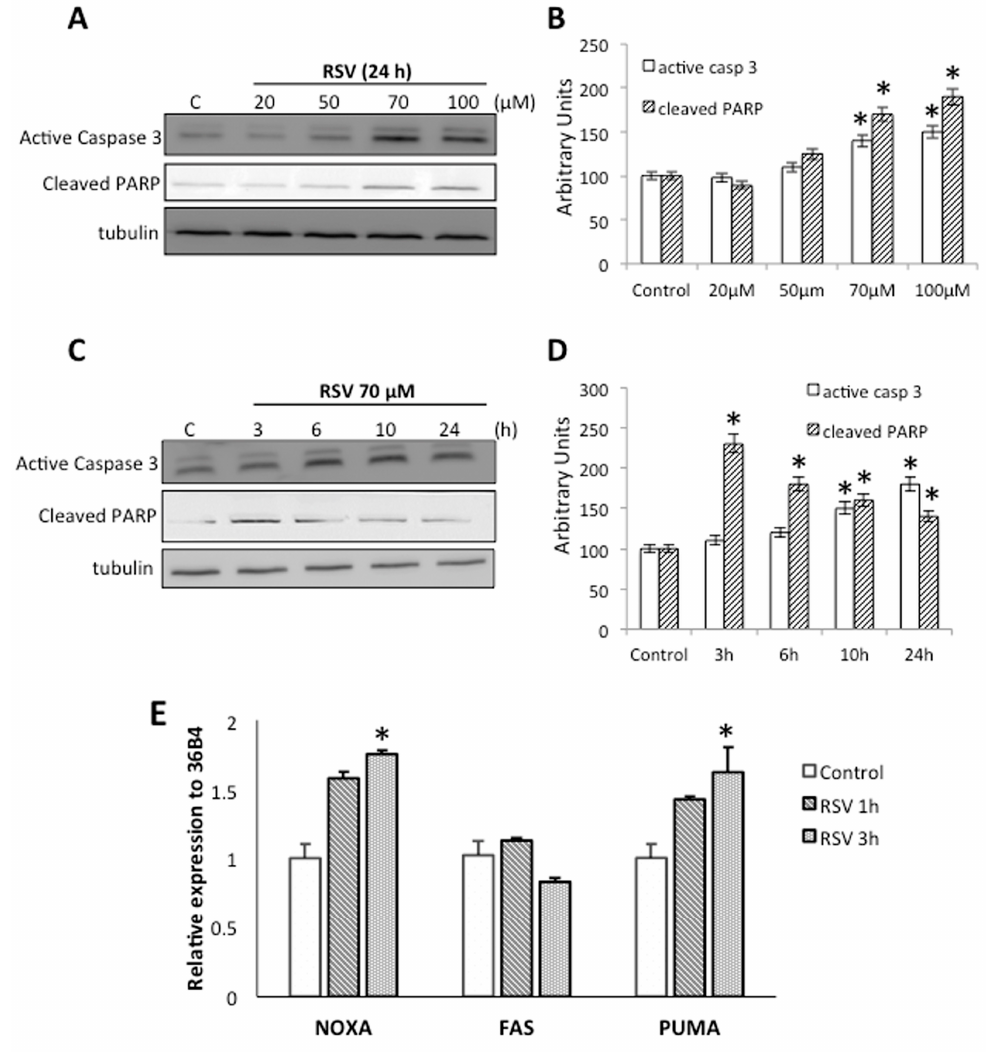
Figure 2. Effect of Resveratrol on apoptosis markers. ( A ) Western blot analysis of proteins from cells treated with different concentrations of resveratrol (RSV) for 24 h using anti-active caspase 3 and anti-cleaved PARP (poly ADP-ribose polymerase) antibodies. Antibodies against total tubulin were used as loading control. ( B ) Quantification of the proteins shown in panel A is represented as a column plot with error bars. ( C ) Western blot analysis of proteins from cells with 70 µM RSV for different time periods using anti-active caspase3 and anti-cleaved PARP antibodies. Antibodies against total tubulin were used as loading control. ( D ) Quantification of the proteins shown in panel C is represented as a column plot with error bars. ( E ) The mRNA levels of apoptotic-related genes were measured by quantitative reverse transcriptase polymerase chain reaction (NOXA; Phorbol-12-myristate-13-acetate-induced protein 1, FAS; Tumor necrosis factor receptor superfamily member 6 and PUMA; p53 up-regulated modulator of apoptosis). Cells were treated with 70 µM RSV for 1 h or 3 h. Results are representative of three independent experiments, * p < 0.05 compared to control cells.